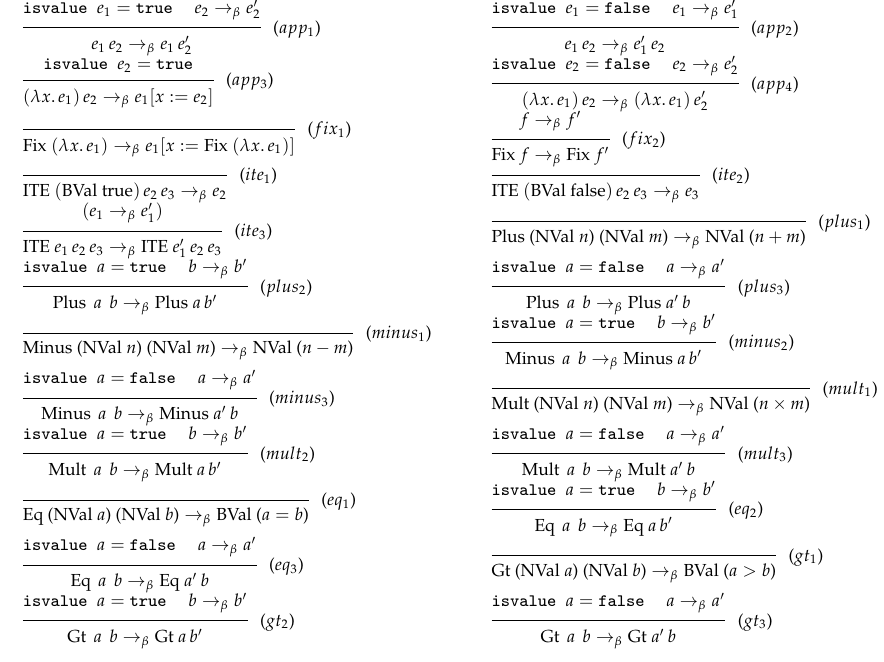
Figure 2. Small-step CBV